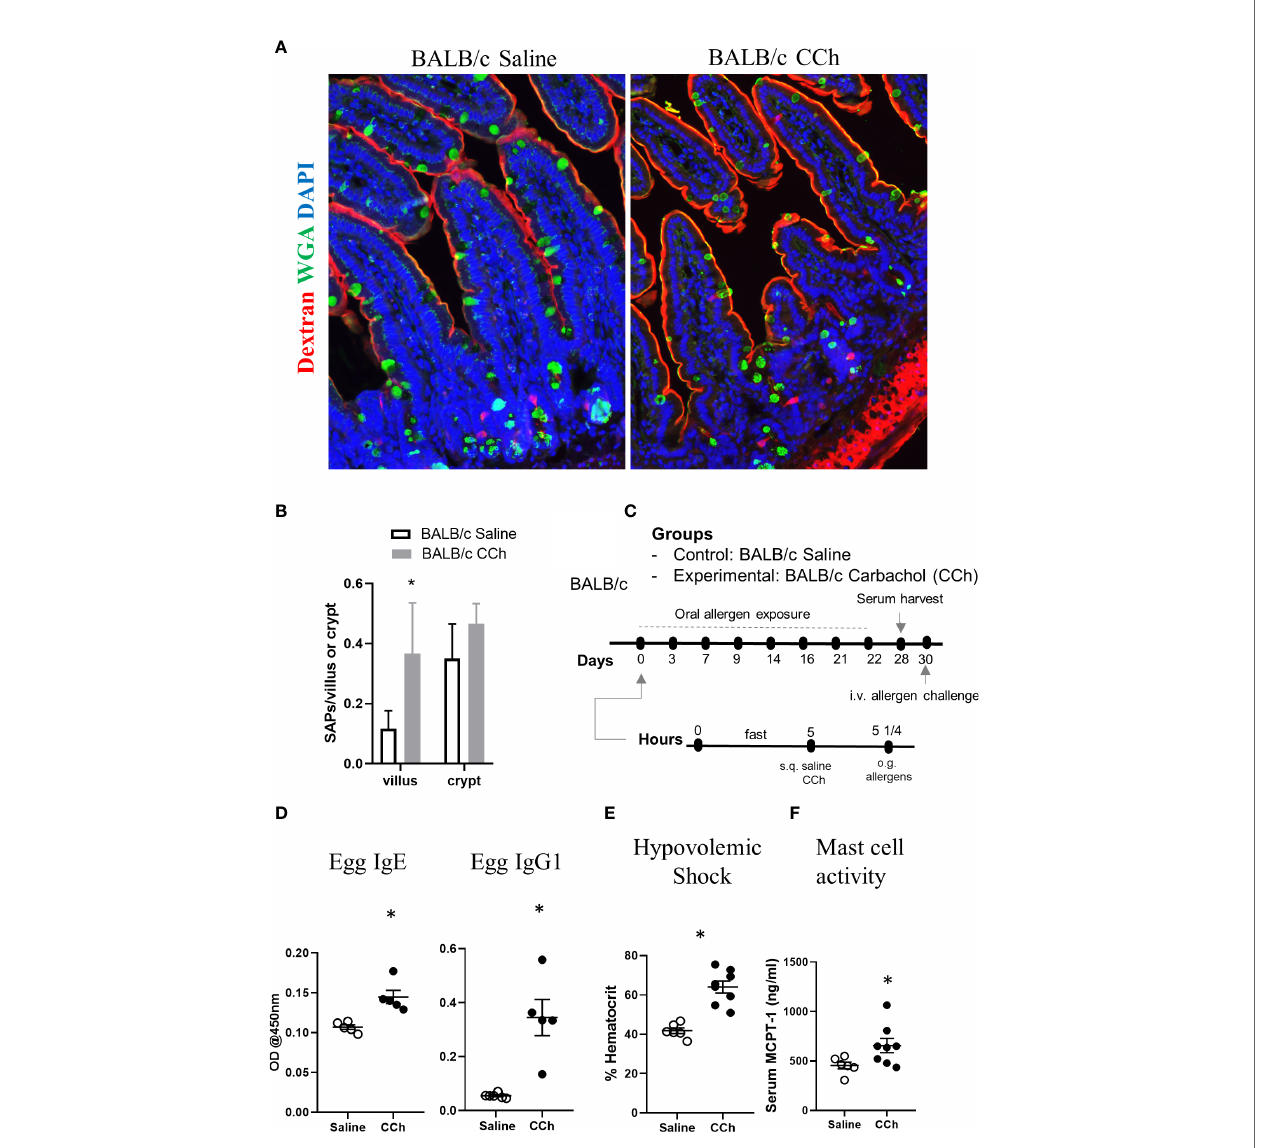
FIGURE 7 | Thermoneutral housing temperature alters cellular and structural patterning of antigen passage formation and allows adjuvant free food sensitization upon activation of antigen passage formation in BALB/c mice. (A) Immuno fl uorescence analysis for WGA (green) and dextran (red) with the small intestine of BALB/c mice treated with saline or CCh that are housed at the thermoneutral temperature. (B) Quanti fi cation of antigen passage formation for villi and crypts. n=3 per group. (C) Experimental scheme of oral sensitization with BALB/c mice. (D) Egg speci fi c IgE and IgG1 in the serum of saline or CCh treated BALB/c mice housed at the thermoneutral housing temperature at day 28. The graphs show representative results, and the experiment was repeated once. (E) % hematocrit and (F) serum MCPT-1 level following the systemic allergen challenge at day 30. *denotes statistical signi fi